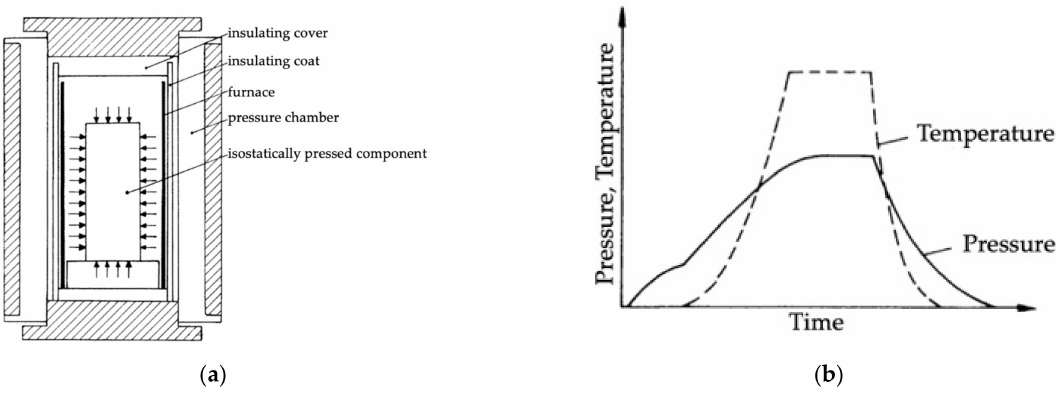
Figure 2. ( a ) Pressure chamber of the HIP system and ( b ) pressure and temperature curve as a function of time [30].